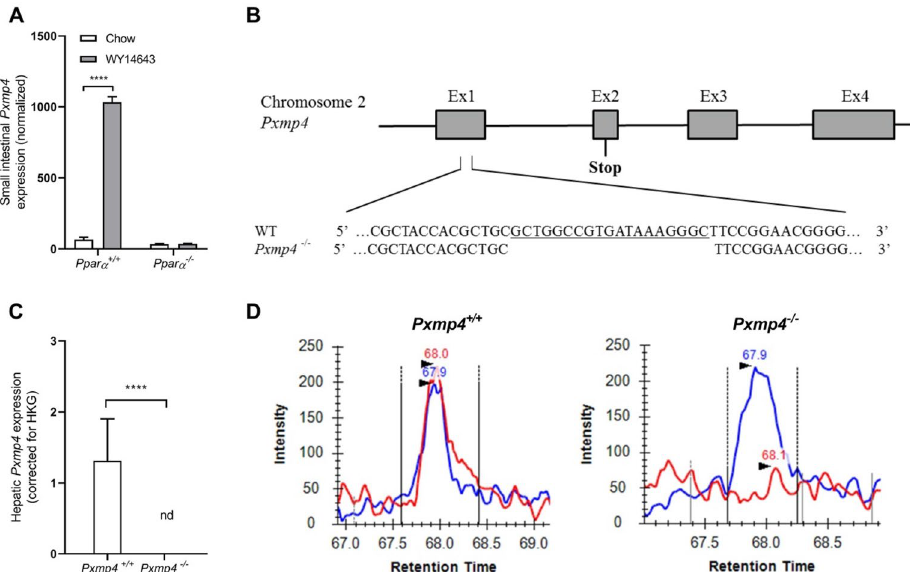
Figure 1. Generation and validation of PXMP4 knockout ( Pxmp4 −/− ) mice. ( A ) Small intestinal Pxmp4 levels in wild type ( Pparα +/+ ) and Pparα -deficient ( Pparα −/− ) mice; ( B ) Schematic representation of the Pxmp4 gene. A 19 bp deletion in exon 1 was introduced by targeted CRISPR/Cas9 gene editing resulting in a premature stop codon in exon 2; ( C ) Hepatic mRNA levels of Pxmp4 ; ( D ) Targeted proteomic analysis of PXMP4 protein in livers of Pxmp4 −/− mice and wild type littermates (n = 5–6). The blue line represents the internal standard and the red line the endogenous levels of PXMP4. Data in figure ( A ) and ( C ) are represented as mean ± SD and statistical significance was tested by a